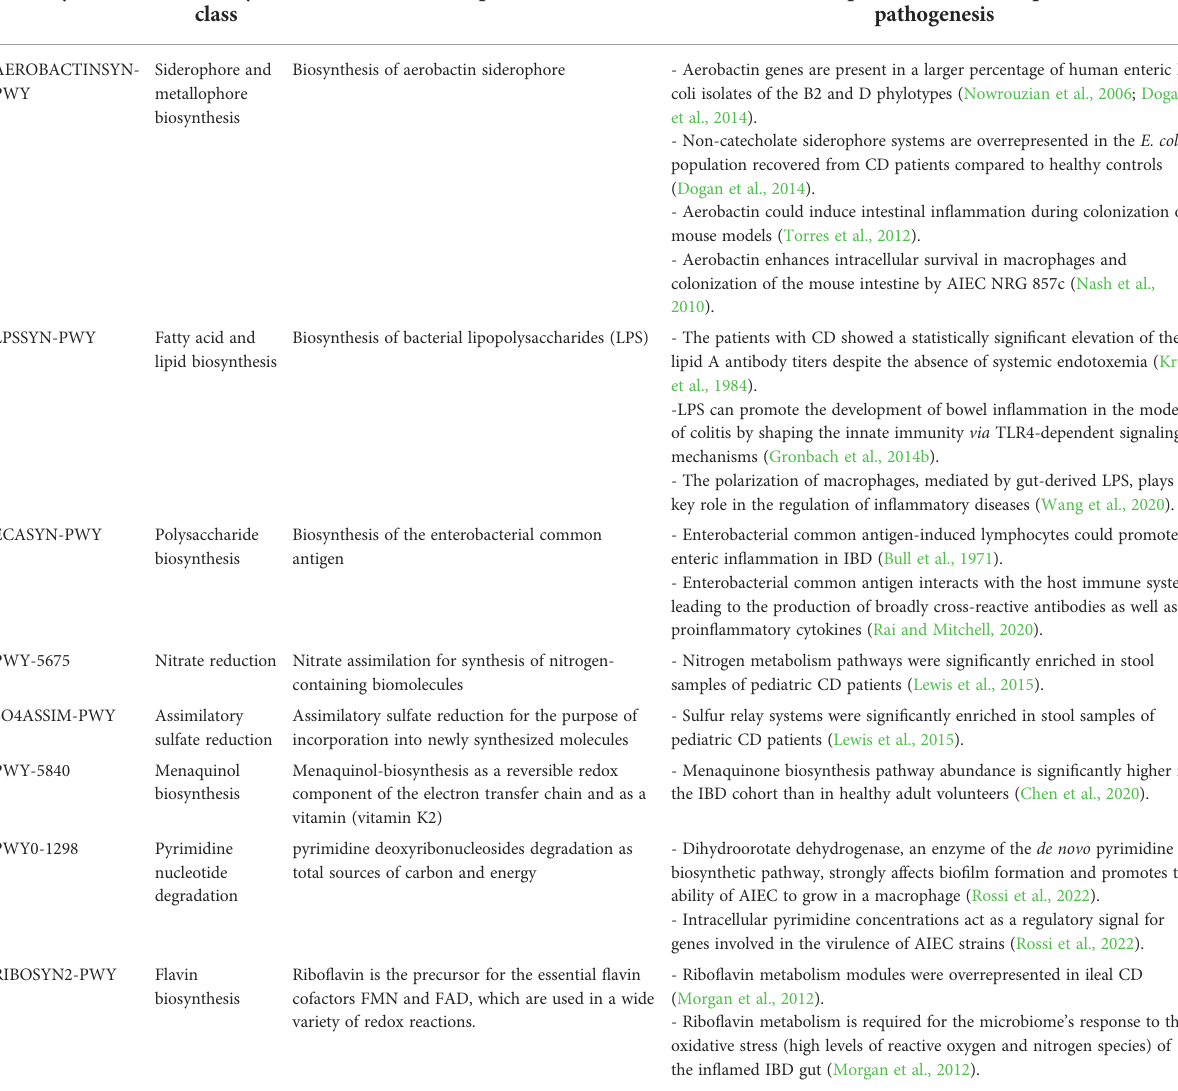
TABLE 1 Major metabolic pathways used by Enterobacteriaceae species and their associations with CD and UC.